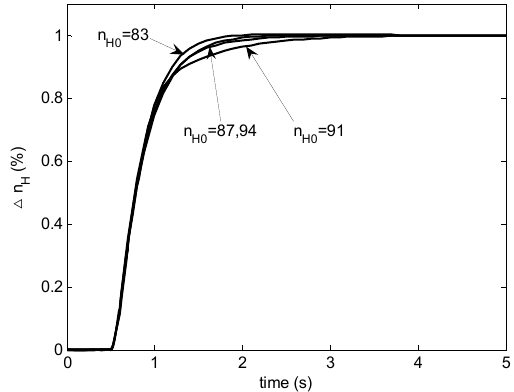
Figure 15 Step responses with the frozen-parameter H ∞ controller.